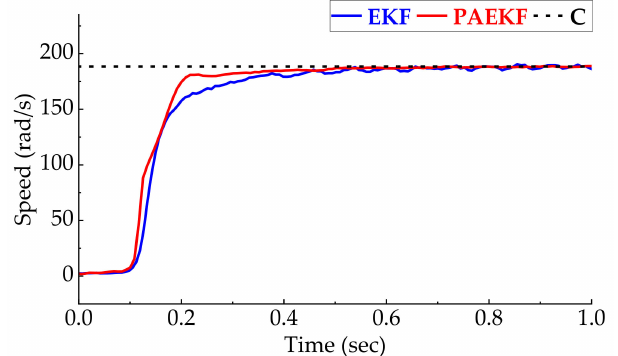
Figure 9. Experimental results of PMSM control system based on EKF and PAEKF.